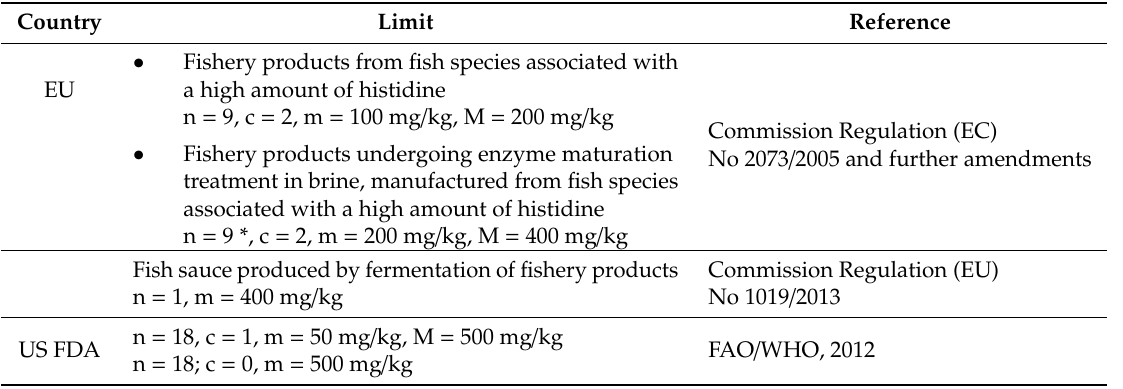
Table 6. Sampling plan for histamine determination according to o ffi cial control